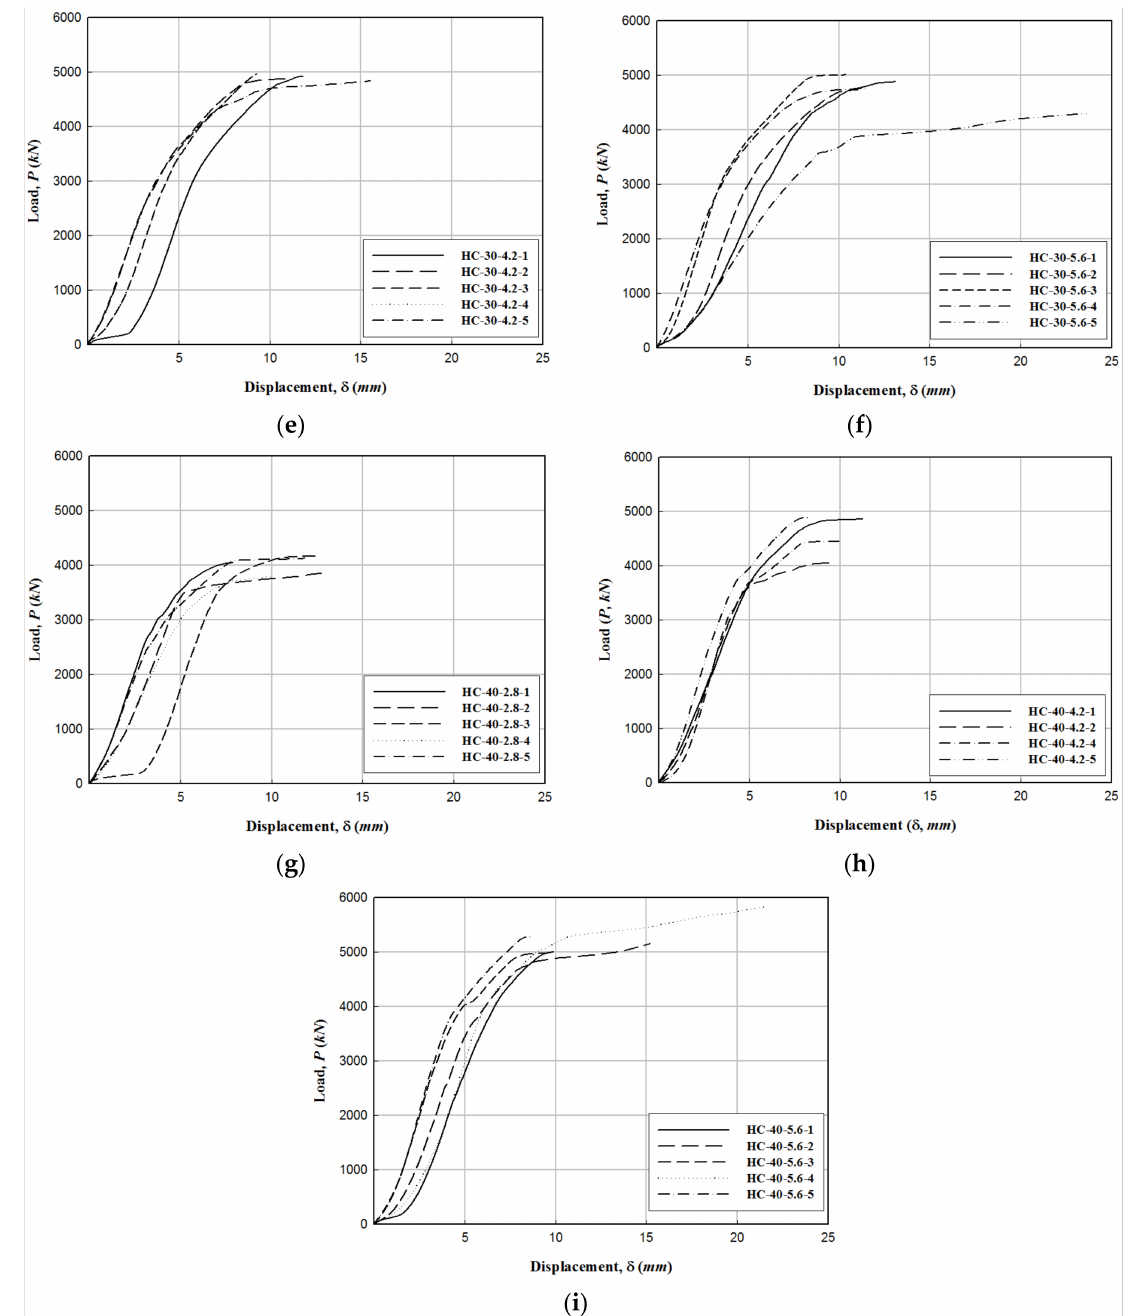
Figure 15. Load–displacement relationship of the hybrid-CFFT: ( a ) HC-21-2.8, ( b ) HC-21-4.2, ( c ) HC-21-5.6, ( d )